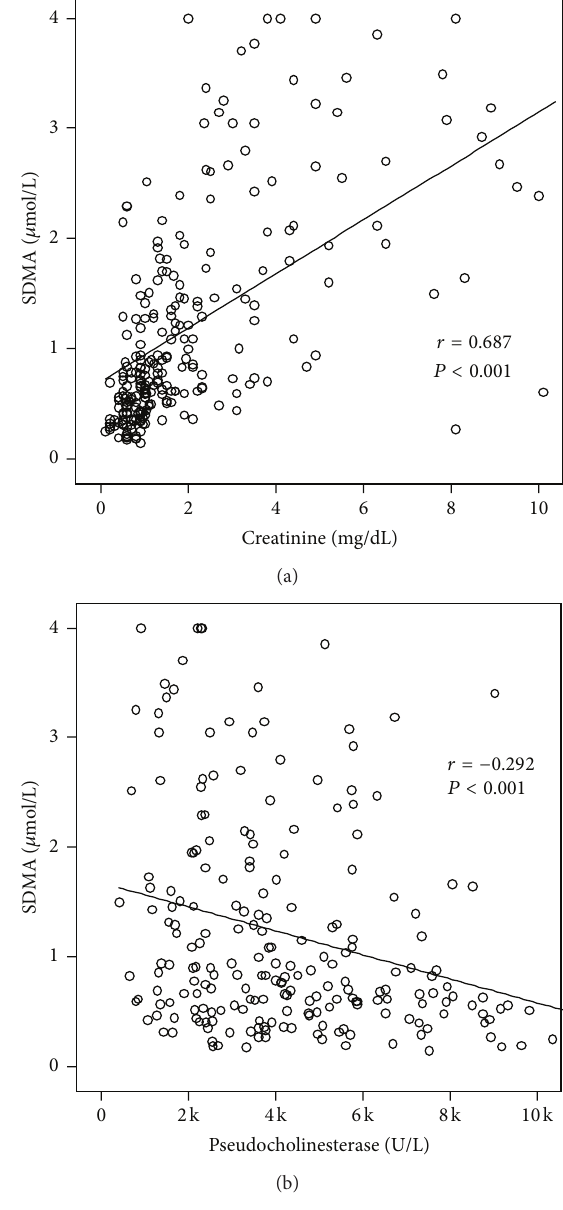
Figure 2: Serum SDMA concentrations in critically ill patients are correlated with renal and hepatic organ failure. Serum ADMA levels were measured in 𝑛 = 247 critically ill patients at admission to the ICU. Serum SDMA correlated significantly with renal failure (crea- tinine, (a)) or hepatic failure (pseudocholinesterase, (b)). Spearman rank correlation test, 𝑟 and 𝑃 values are given in the